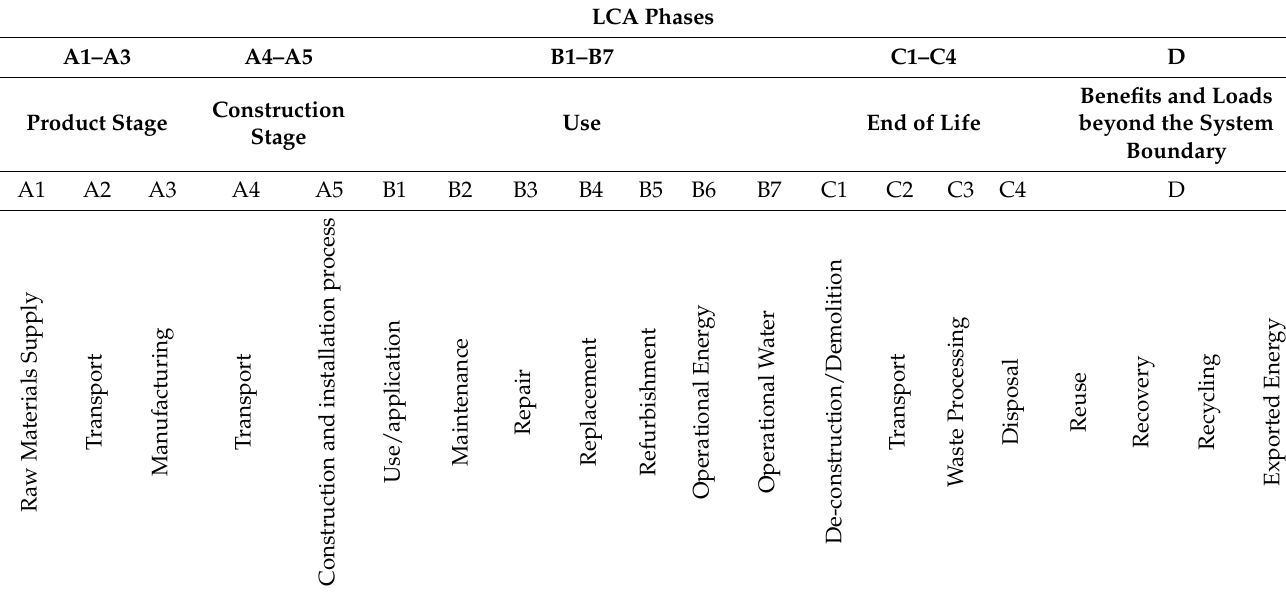
Table 2. Complete phases of the LCA analysis